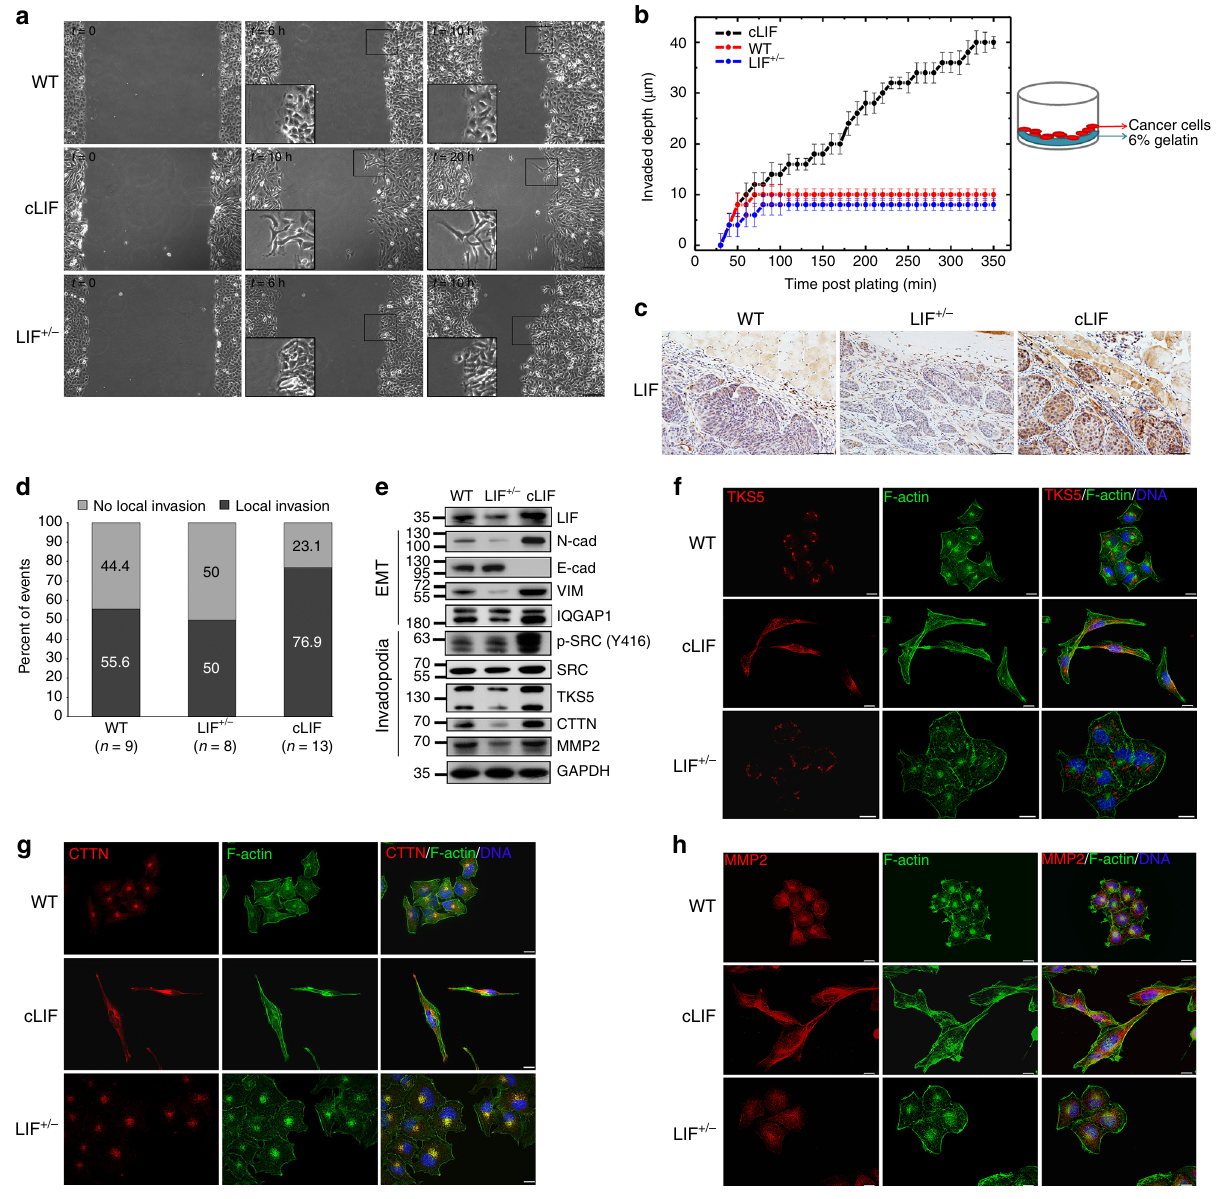
Fig. 3 Cytoplasmic LIF regulates EMT and invadopodia formation. a Migration pattern analysis using time-lapse live imaging in wound-healing experiments. Scale bars, 100 μ m. See also Supplementary movies 1 – 3. b 3D-gelatin invasion assays. The invasion depth of cancer cells through a stiff gelatin matrix (6%) were measured by time-lapse phase contrast vertical scanning (Olympus IX83). Values are presented as means ± SD of triplicate experiments. c Representative IHC images of LIF expression in paraf fi n-embedded mouse tumor xenografts. Scale bars, 50 μ m. d Quanti fi cation of mouse tumor xenografts with events of local invasion based on hematoxylin & eosin (HE) staining analysis. e Western blot of EMT and invadopodia markers in wild-type parental, cLIF and LIF + / − cancer cells. GAPDH was used as a loading control. f – h Immuno fl uorescence staining of invadopodia markers: TKS5 ( f ). CTTN ( g ). MMP2 ( h ). Alexa Fluor 488 phalloidin (green) was used to stain F-actin. Blue, nuclear staining. Scale bars, 10 μ